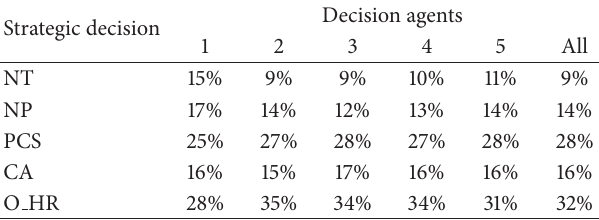
Table 16: Global and individual